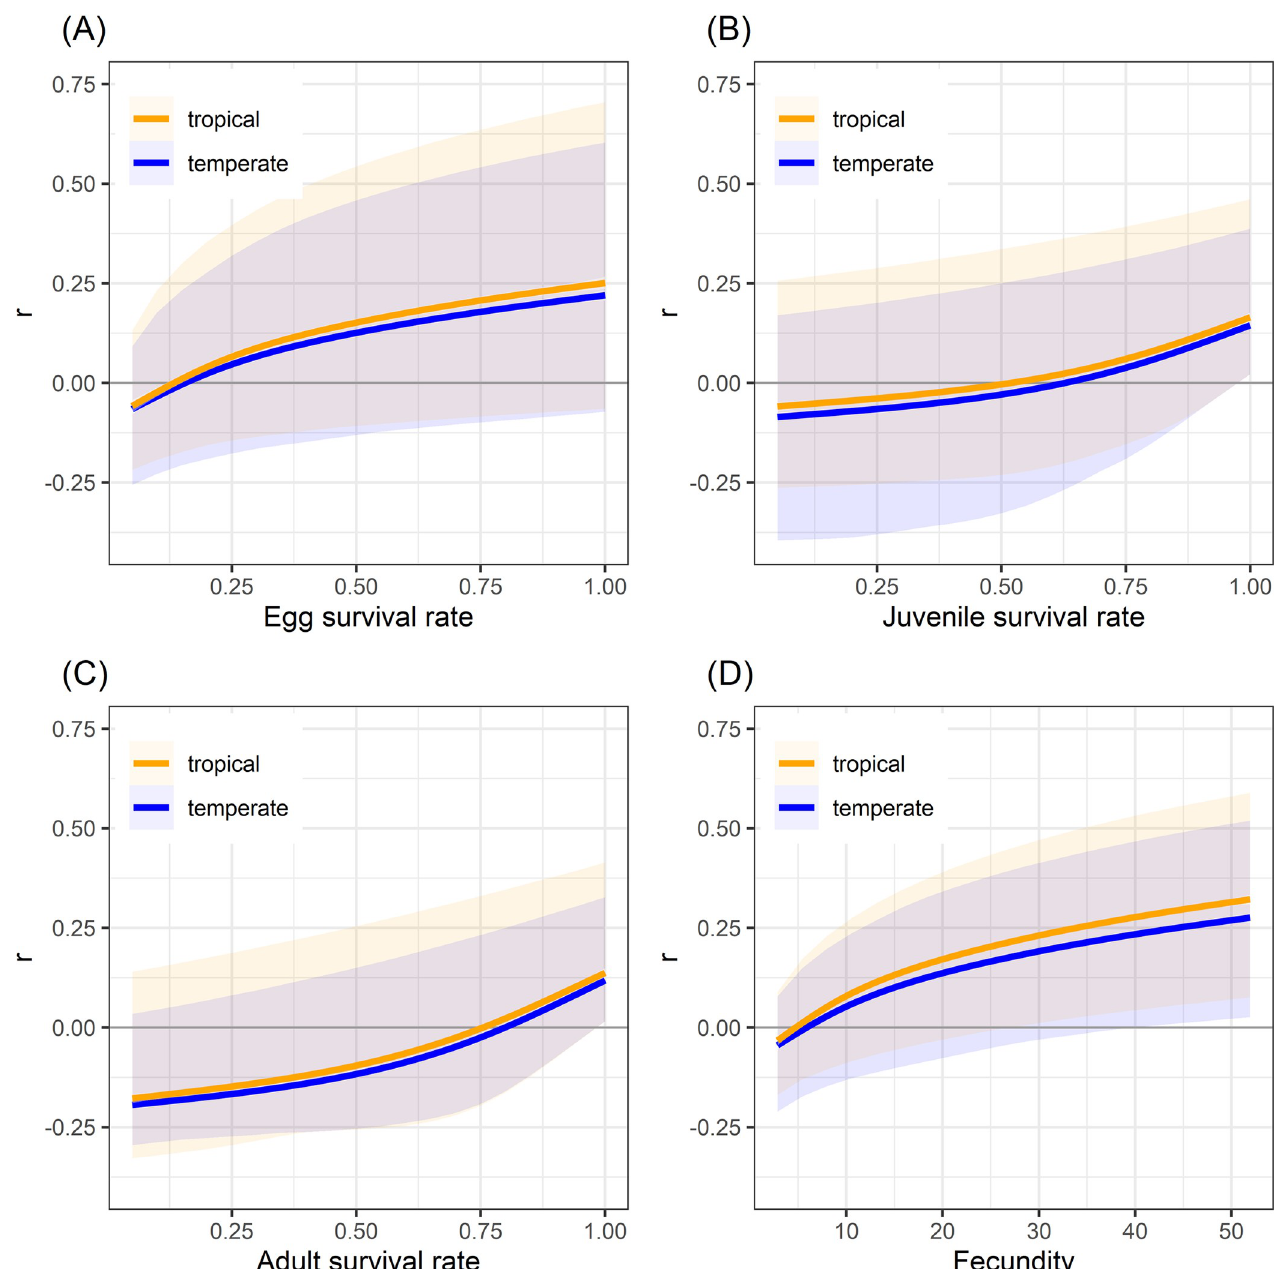
Fig 5. Relationships between intrinsic rate of growth ( r ) and survival rates of (A) egg, (B) juvenile, and (C) adult, and (D) fecundity in freshwater turtles of tropical and temperate zones. Population growth curves (orange and blue lines for temperate and tropical species respectively) were obtained by varying each demographic parameter with all other population parameters held constant. Confidence and prediction intervals were obtained via jackknife randomizations. White shaded polygons show 95% confidence bands. Colored polygons show 95% prediction bands (i.e. include 95% of randomized r